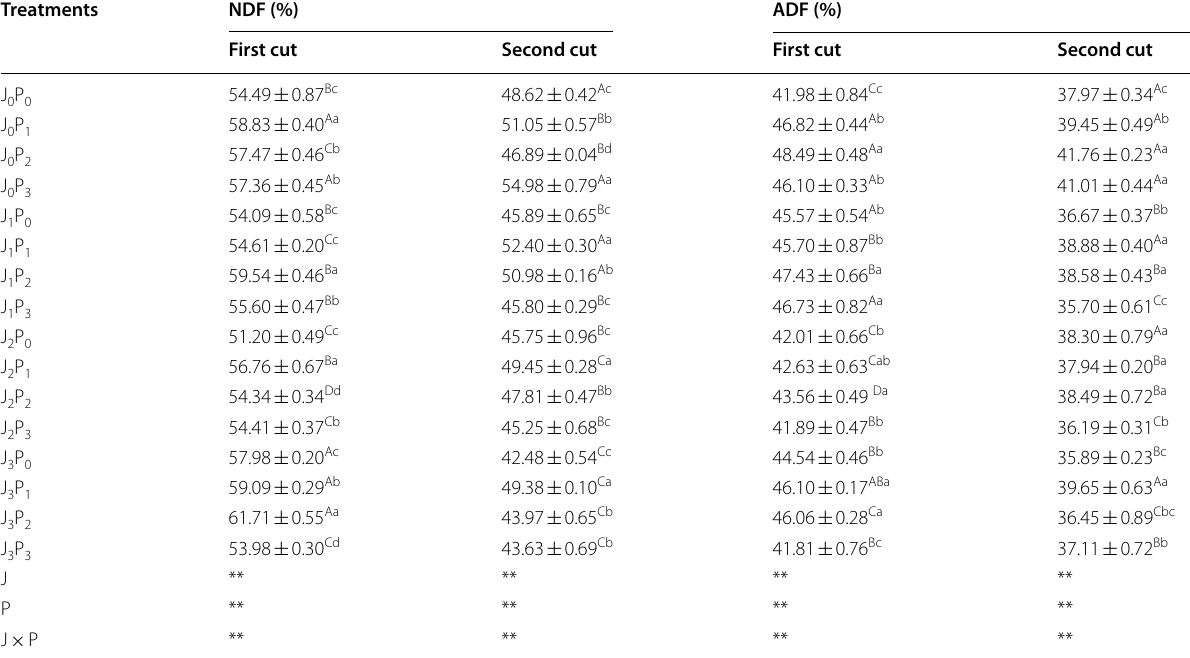
Different capital letters in the same column indicated significant difference in different bacteria treatments under the same phosphorus application conditions ( P < 0.05), differences small letters in the same column mean significant difference under the same bacteria application conditions ( P < 0.05). ** indicates significant difference extremely ( P <